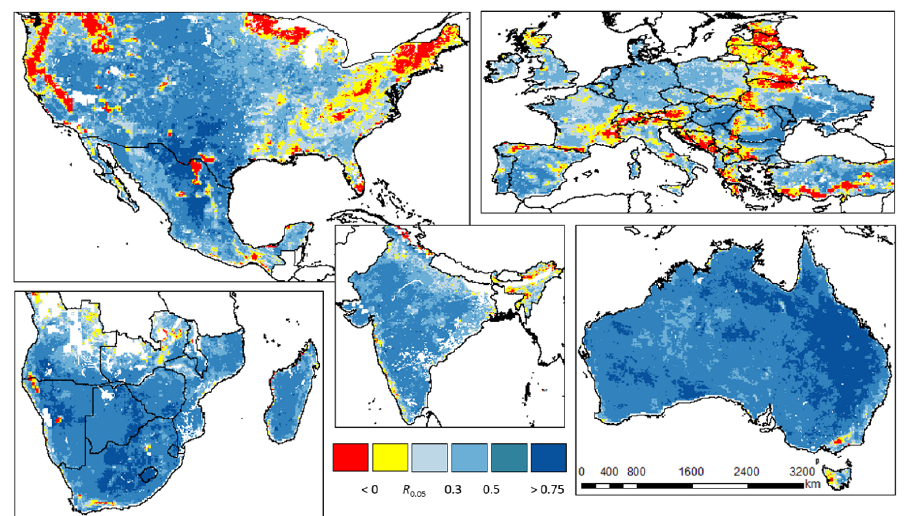
Figure 4. Spatial distribution of the Pearson correlation coefficient ( R) between ESA Climate Change Initiative soil moisture anomalies (CCI) and land surface temperature anomalies (LST) over the five selected macro-regions. Values in red and yellow are negatively correlated or not significant at p = 0.05, respectively.